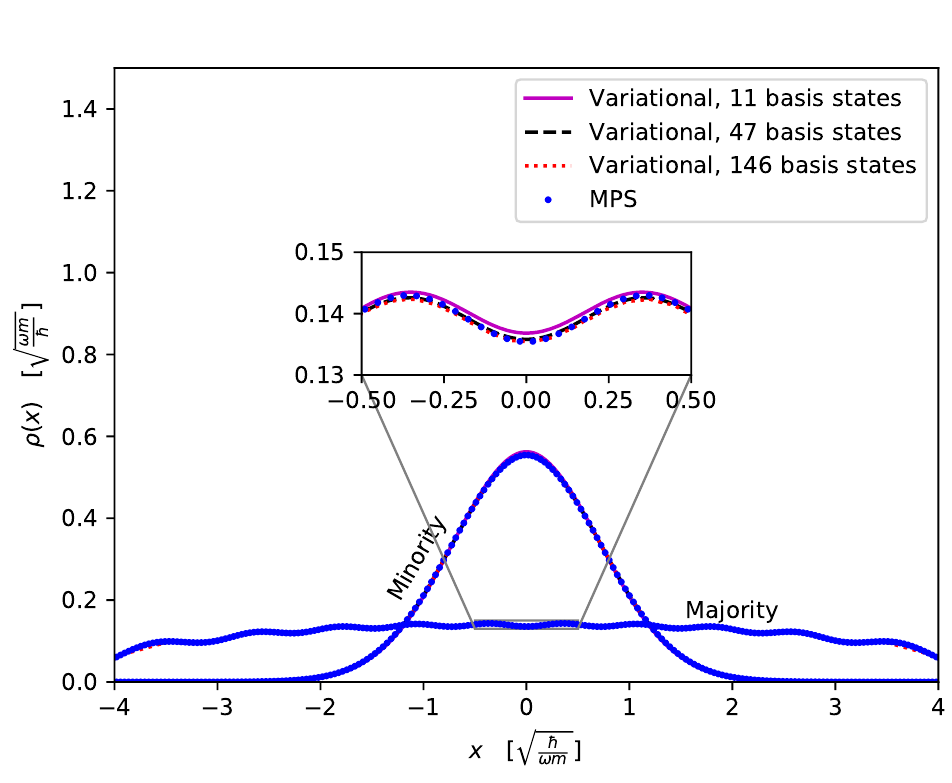
(cid:113) m ħ h 3 ω